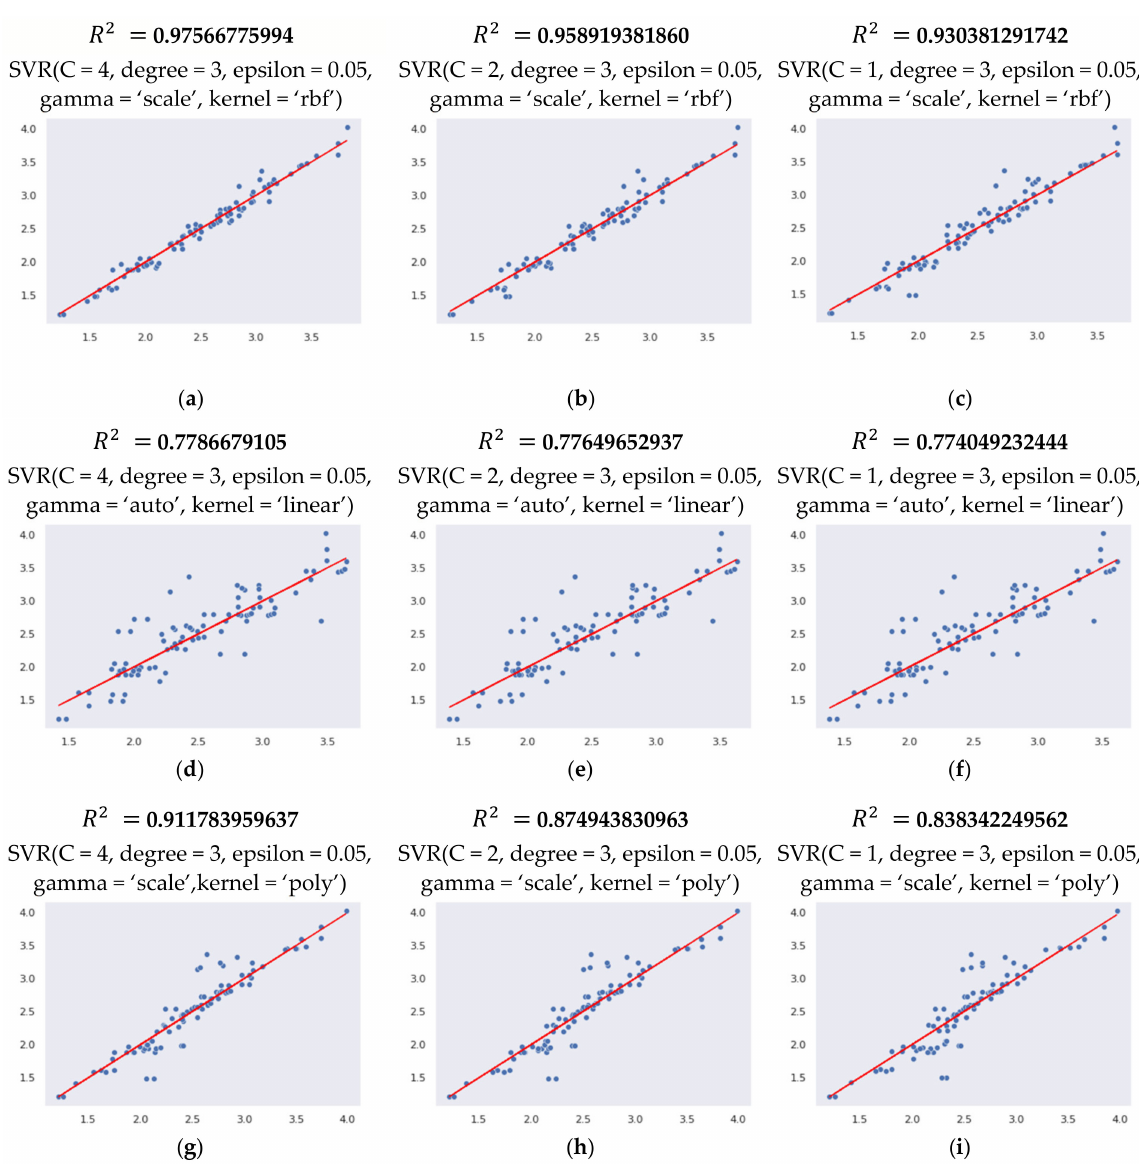
Figure 19. Coefficient of determination R 2 value for RBF-SVR model depending on the number and the type of kernels. ( a )—4 rbf kernels, ( b )—2 rbf kernels, ( c )—1 rbf kernel, ( d )—4 linear kernels, ( e )—2 linear kernels, ( f )—1 linear kernel, ( g )—4 polynomial kernels, ( h )—2 polynomial kernels, ( i )—1 polynomial